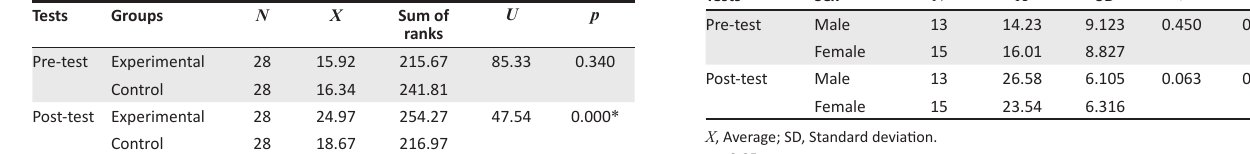
TABLE 2: Mann–Whitney U comparisons of the experimental and control groups’ Brief Infant-Toddler Social and Emotional Assessment pre-test and post- test scores.